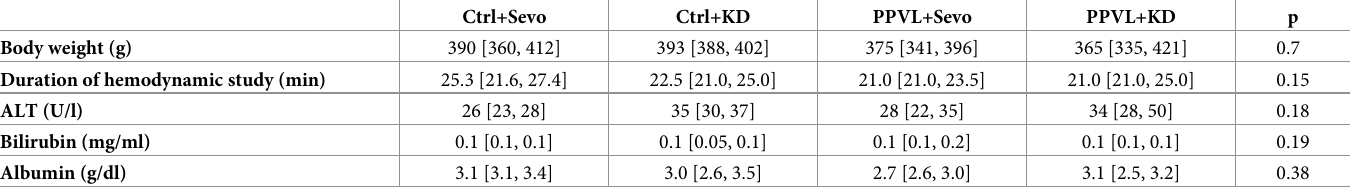
Table 2. Physiological, procedural and blood biochemical parameters of rats at the time of the hemodynamic study. Ctrl+Sevo Ctrl+KD PPVL+Sevo PPVL+KD p Body weight